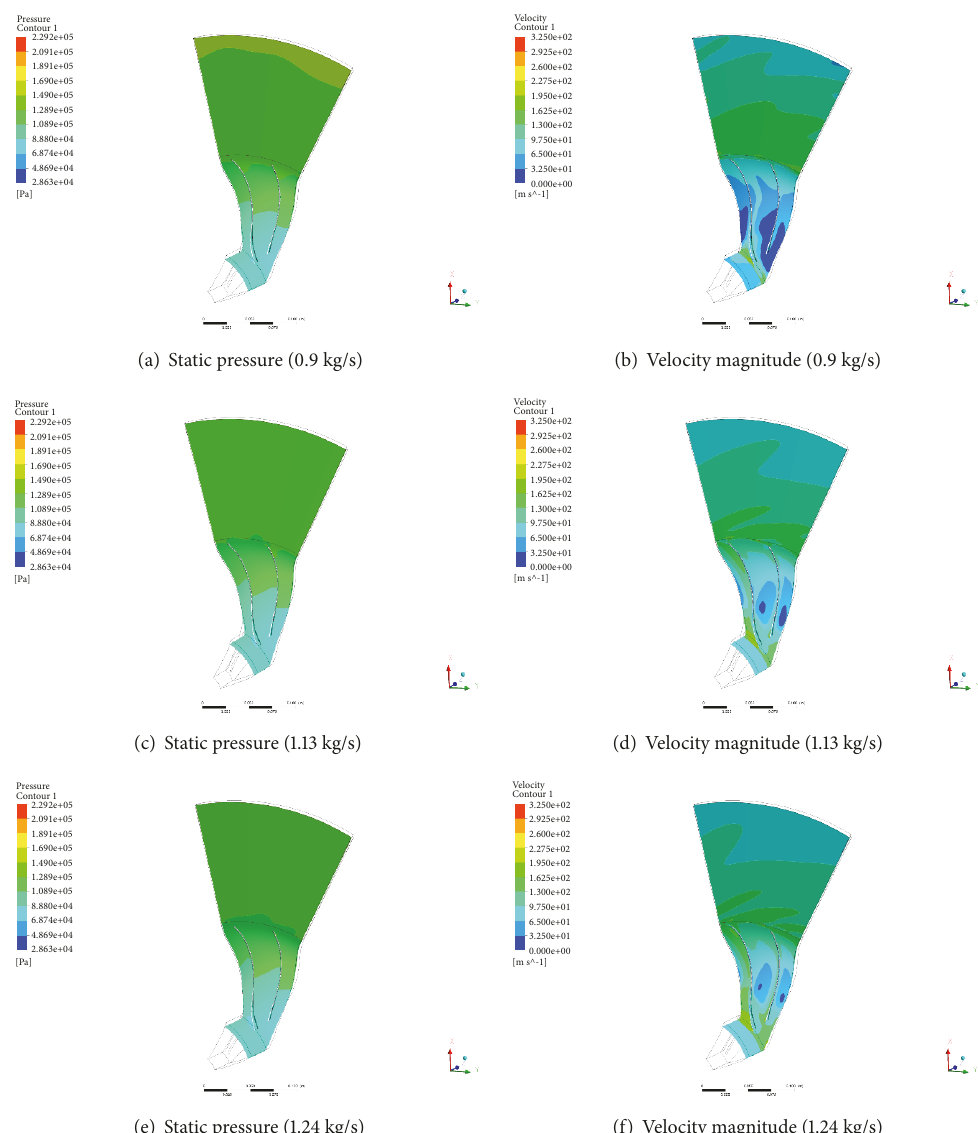
Figure 15: Static pressure and velocity magnitude contours at 322